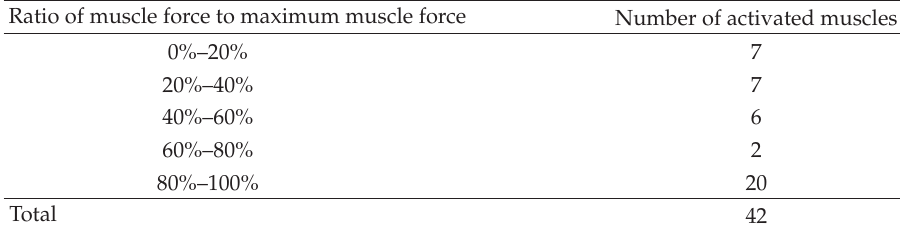
Table 1: The number of activated muscles according to the ratio of muscle force to maximum muscle